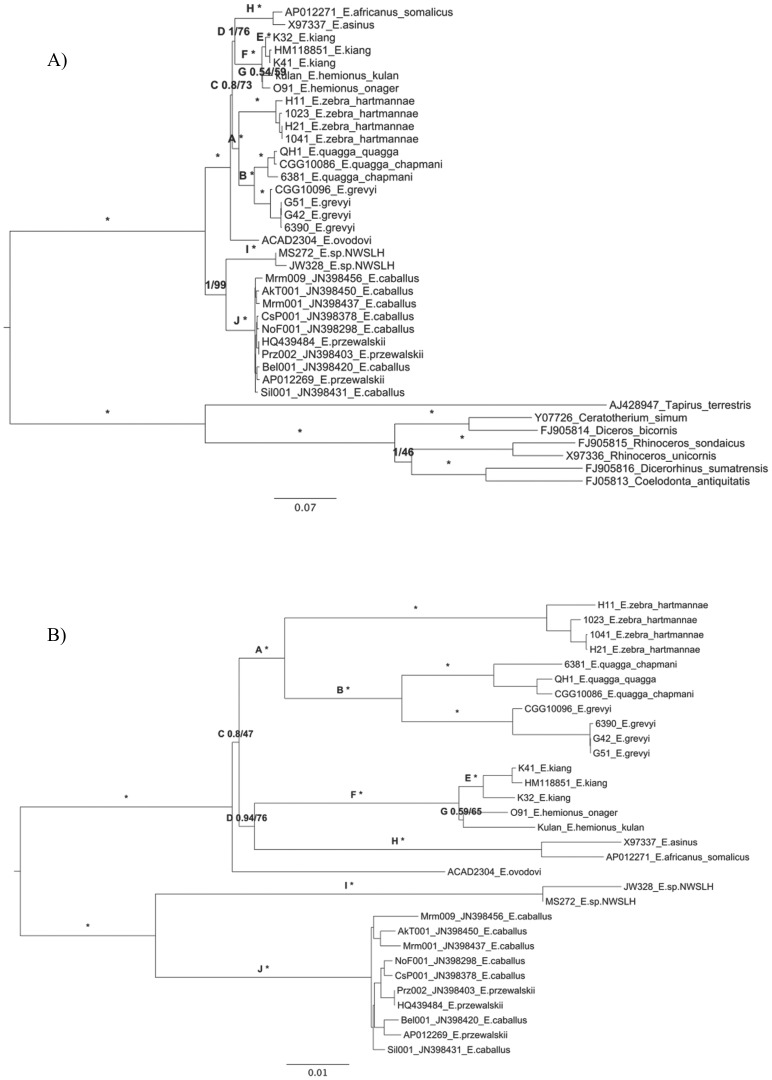
Phylogenetic RAxML trees (GTR+G+I) with 500 bootstraps and MrBayes (GTR+G+I) 50M generations on the full data set.Posterior probabilities are given in proportions and bootstrap support as a percentage on each branch of interest. * Branch is supported by maximum posterior probability and bootstrap (1/100). A: Including outgroups and based on 5 partitions. B: Excluding outgroups and based on 4 partitions.